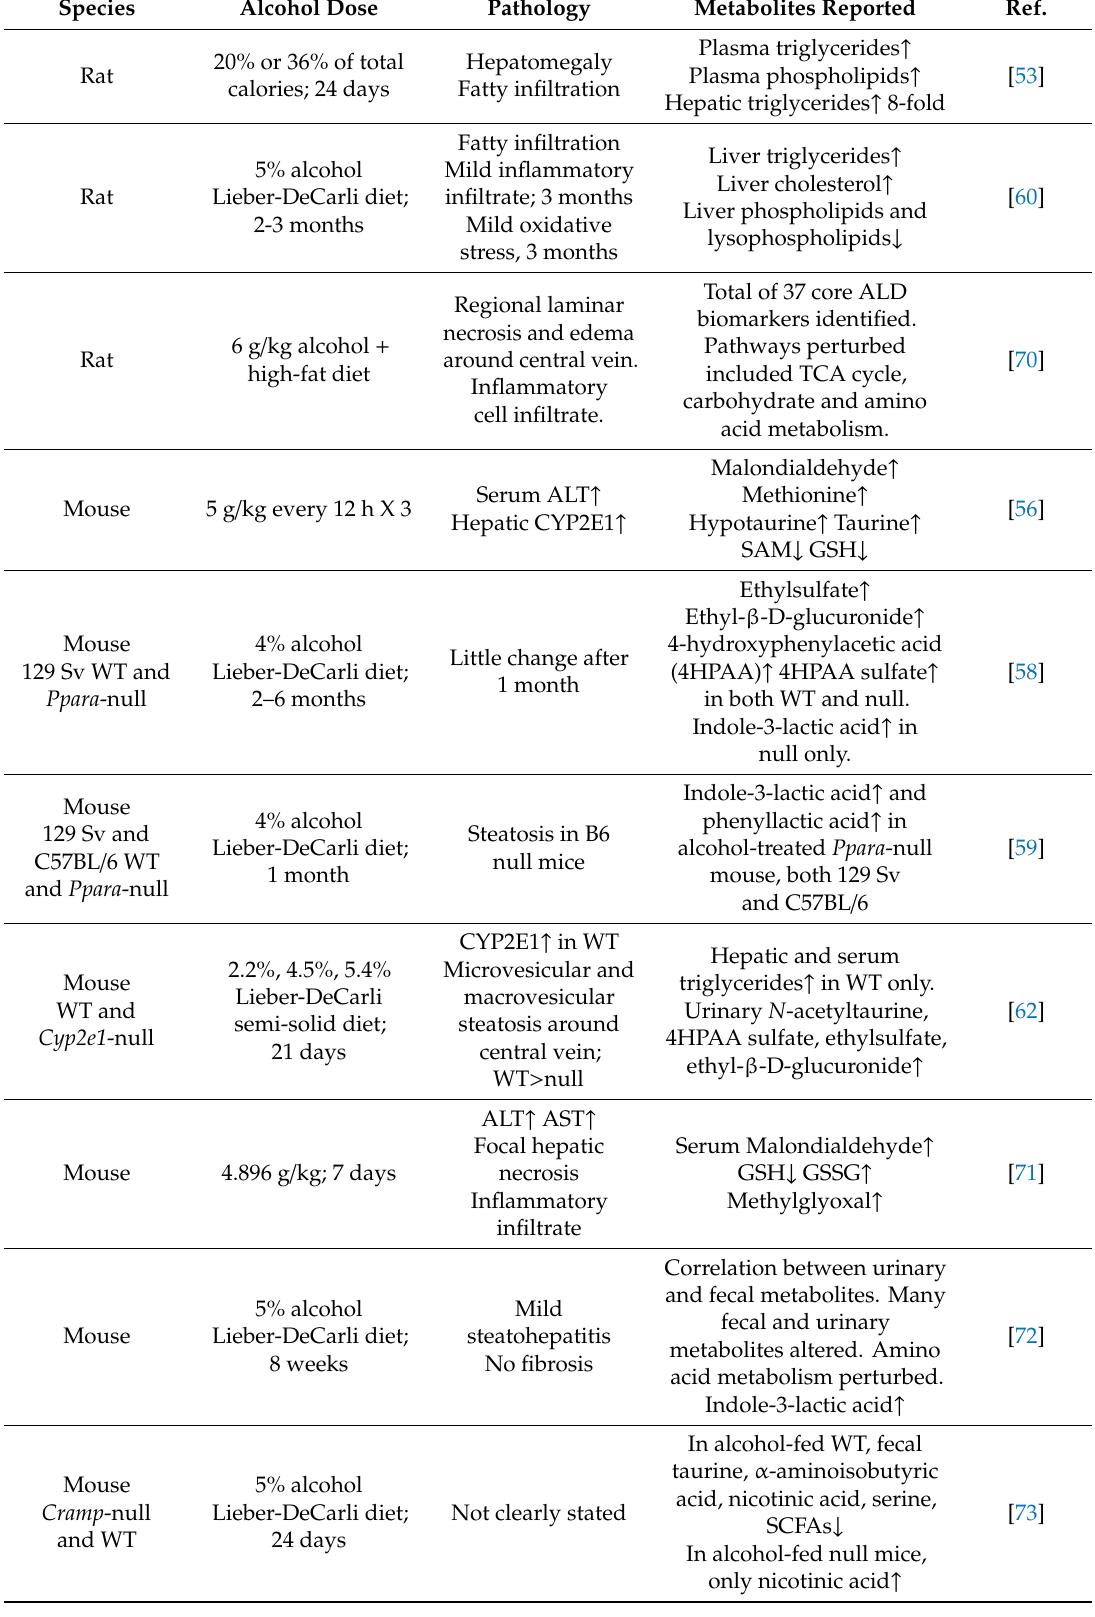
Table 1. Metabolomic and lipidomic biomarkers of alcoholic liver disease.